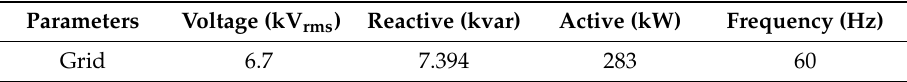
Table 2. Marado Island Power Grid Parameters.